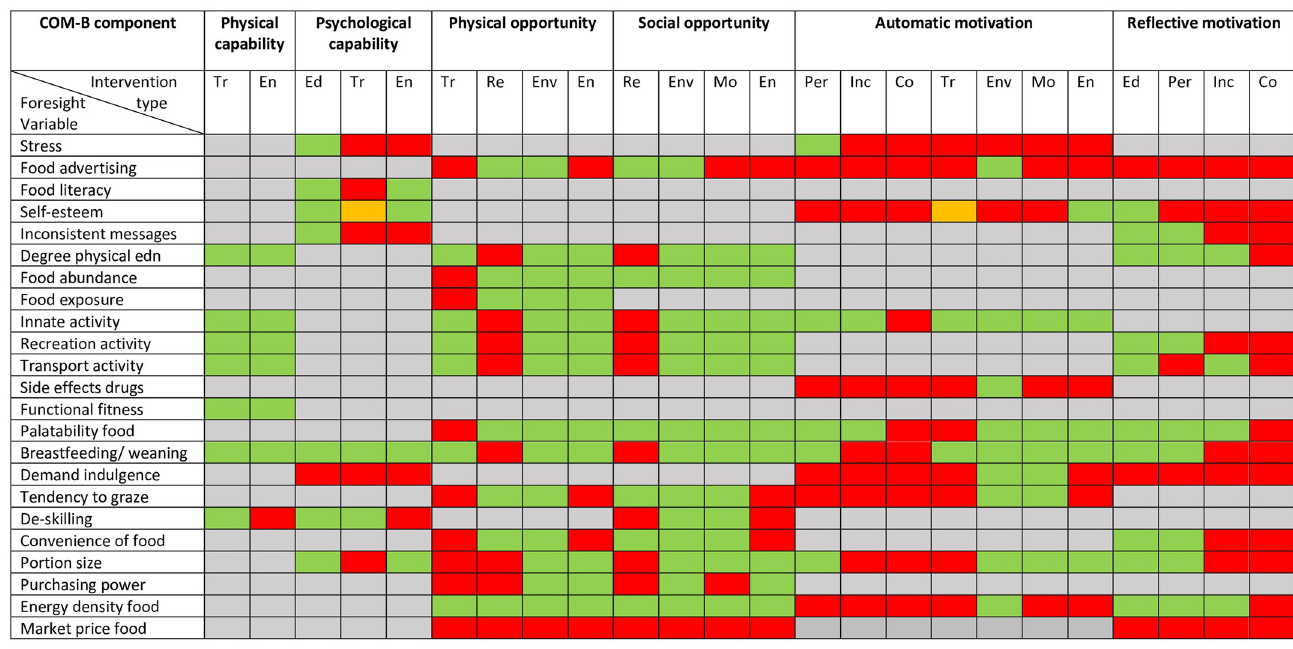
Fig 2. HEAT map showing foresight variables with mapped policy